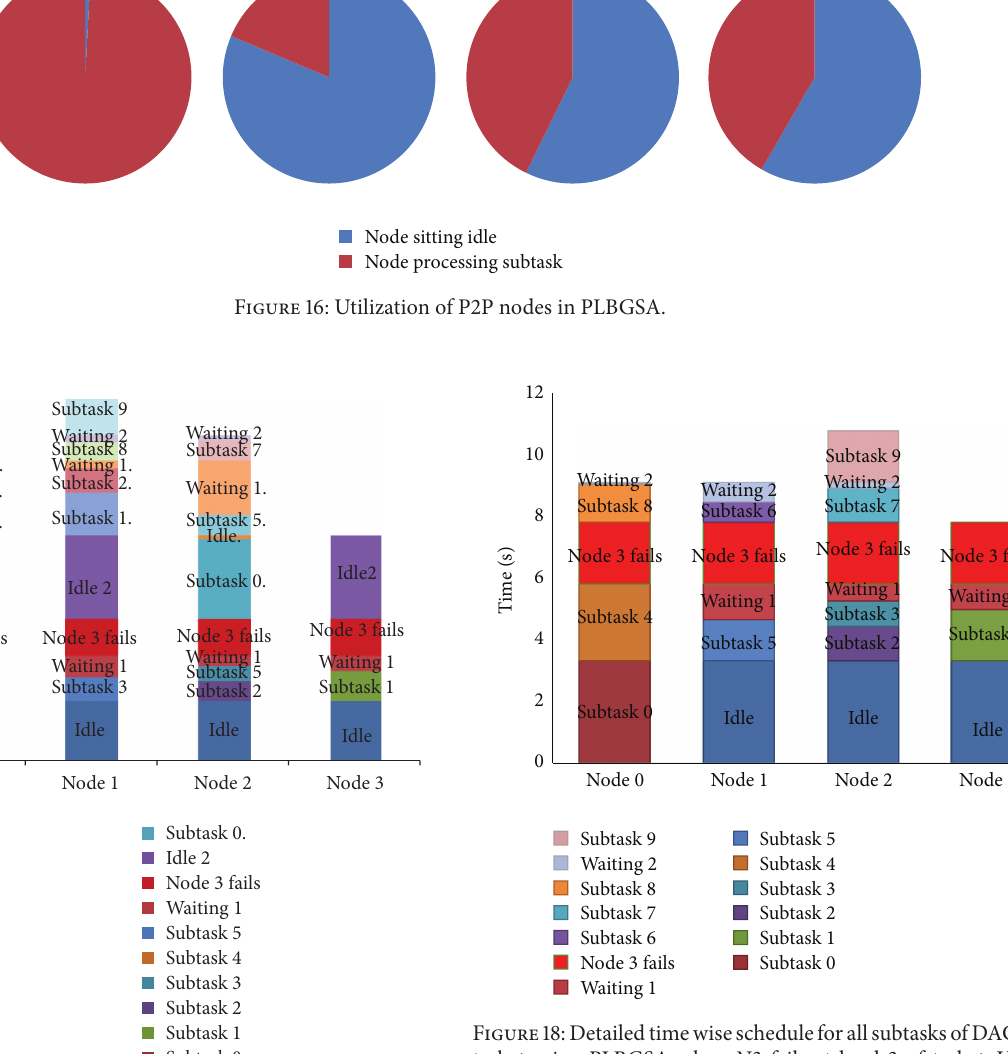
Figure18:DetailedtimewisescheduleforallsubtasksofDAGbased task t using PLBGSA when N 3 fails at level 3 of task t . Here we reschedule using